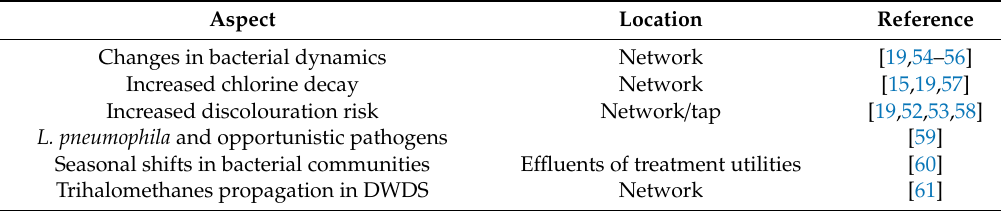
Table 3. Scientific studies on the e ff ects of temperature in the distribution network or at the